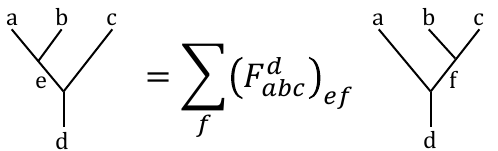
Figure 5: Fusion diagrams and F -matrices. A basis in the fusion space is given by choosing an order in which the anyons are to be fused without exchanging their positions (this results in a unitary evolution in the fusion space as discussed in the next subsection). In the case of three anyons a , b and c that are constrained to fuse to d , there are only two options: Either they are fused pairwise from left to right ( | ( ab ) c ; ec ; d 〉 ) or from right to left ( | a ( bc ) ; a f ; d 〉 ). These two bases are related by the unitary matrix F d according to (12). The state in one basis is in abc general a superposition of the basis states in the other